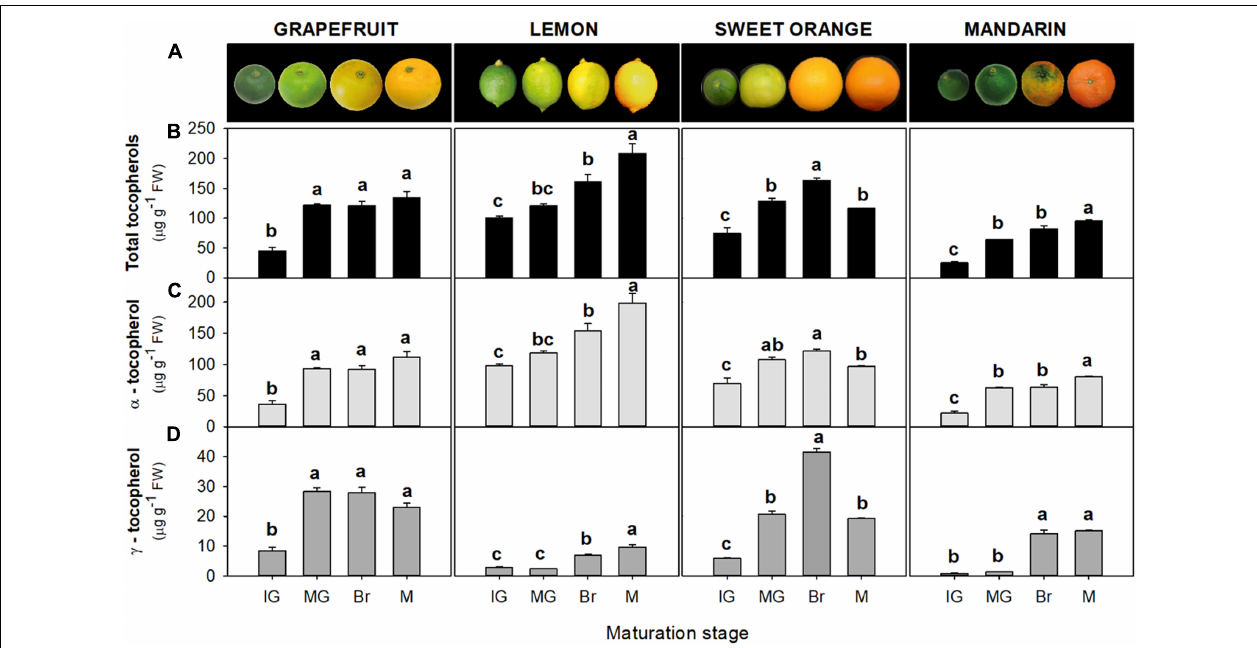
FIGURE 2 | Fruit external appearance (A) and total tocopherol (B) , α -tocopherol (C) , and γ -tocopherol content (D) in the flavedo during fruit maturation of grapefruit ( C. paradisi ), lemon ( C. limon ), sweet orange ( C. sinensis ), and mandarin ( C. clementine ). Contents are expressed as µ g g – 1 of fresh weight. The data are mean ± SE of at least two replicates ( Supplementary Table 9 ). Maturation stages correspond to immature green (IG), mature green (MG), breaker (Br), and mature (M). Different letters indicate significant mean differences among maturation stages for each fruit specie (Tukey’s test, p ≤